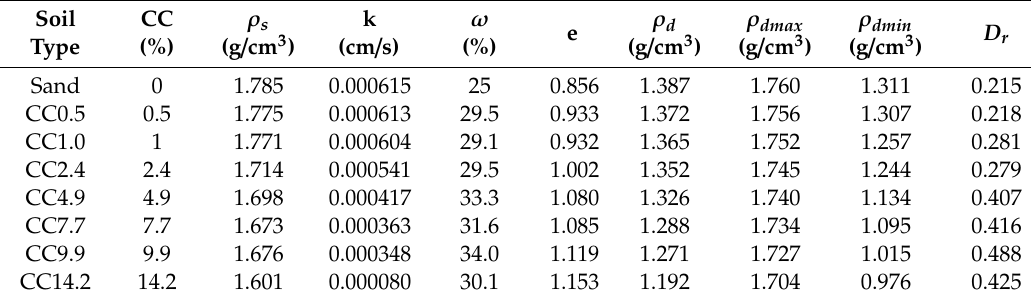
Table 1. Properties of soil samples.